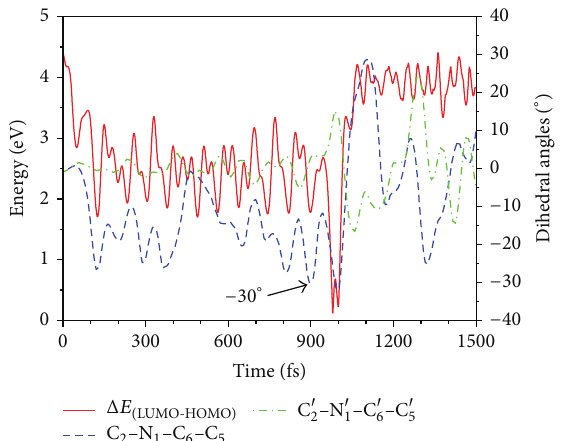
Figure 4: Variations with time of the dihedral angles C 2 –N 1 –C 6 –C 5